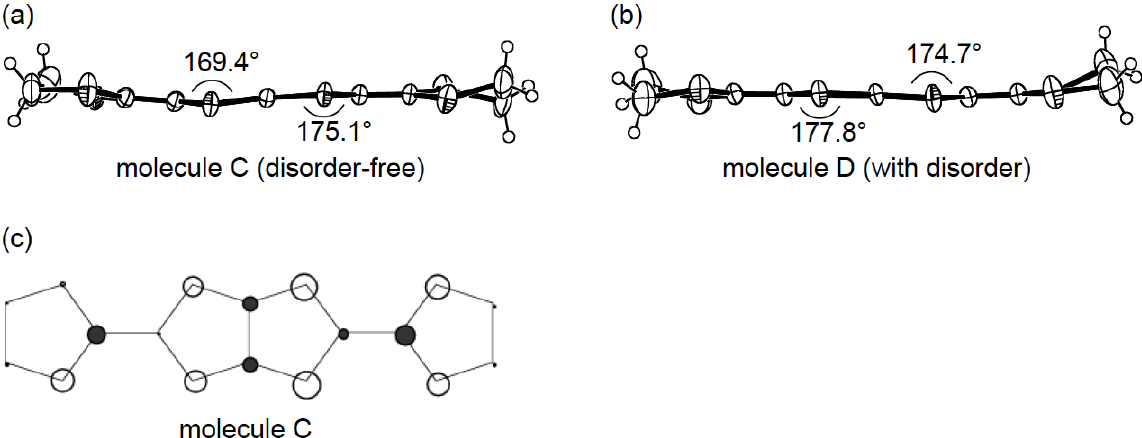
Figure 22. Structures of molecules ( a ) C and ( b ) D in α-(DHOT-TTP) of molecule